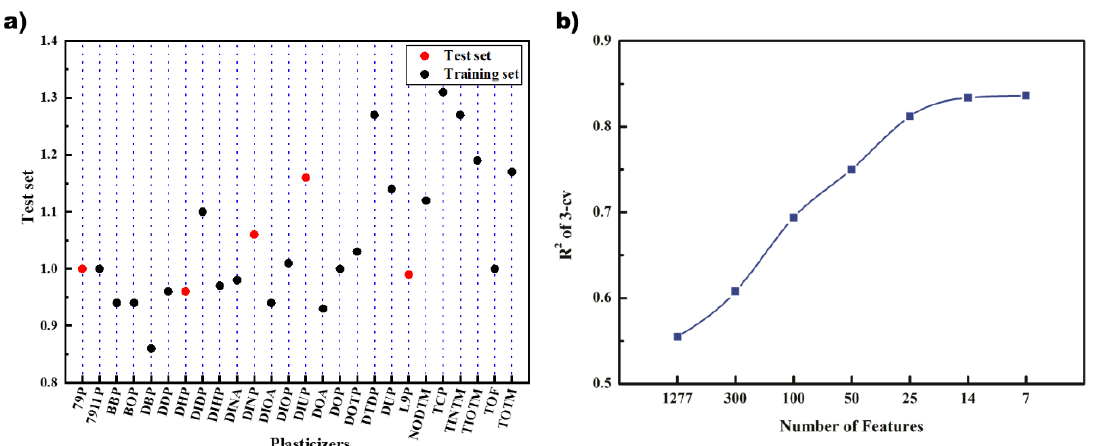
Figure 2. ( a ) Data set division; ( b ) convergence of genetic algorithm iteration.